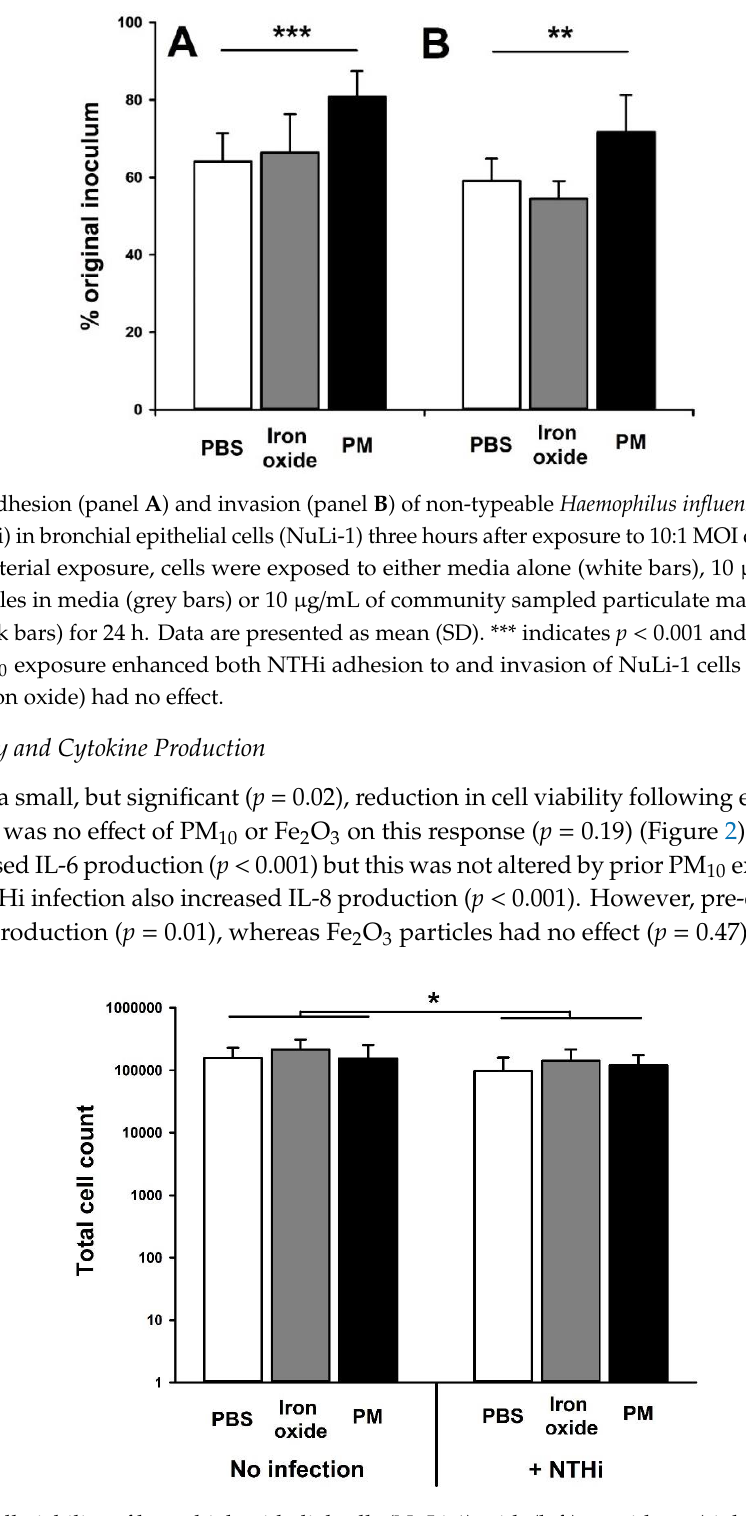
Figure 2. Cell viability of bronchial epithelial cells (NuLi-1) with (left) or without (right) three hours of exposure to 10:1 MOI of non-typeable Haemophilus influenzae (86-028NP strain; NTHi)). Prior to bacterial exposure, cells were exposed to either media alone (white bars), 10 µ g / mL of iron oxide particles in media (grey bars) or 10 µ g / mL of community sampled PM 10 in media (black bars) for 24 h. Data are presented as mean (SD). * indicates p < 0.05. Cell viability was reduced by NTHi exposure but was not altered by particle